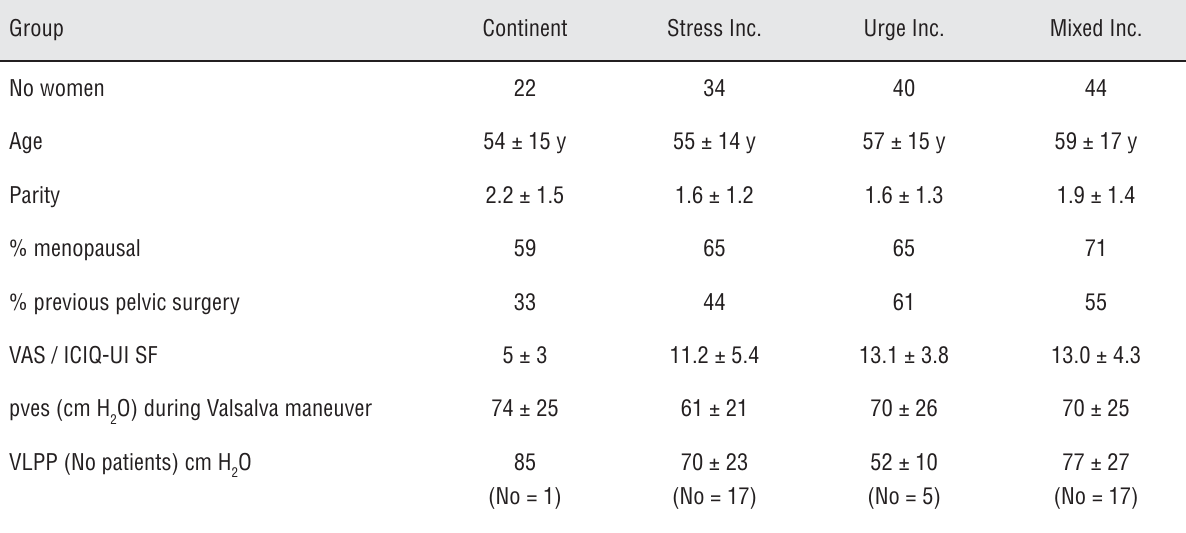
Table 1 - Patients’ characteristics. Data are given as mean ± standard deviation. Group Continent Stress Inc. Urge Inc. Mixed